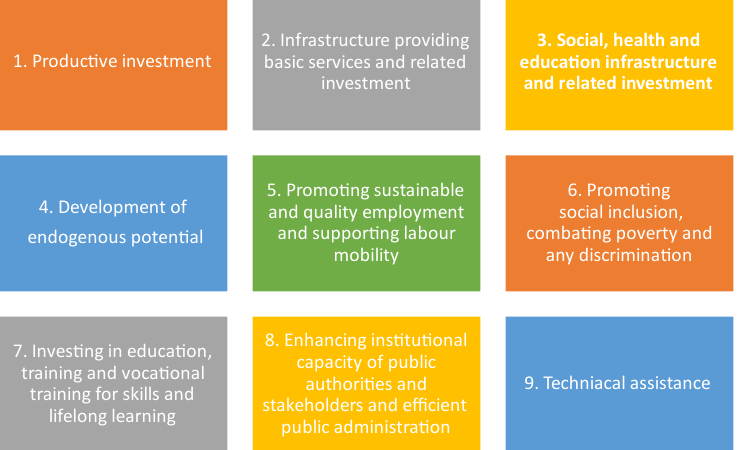
Figure 13. Groups of Interventions in European Regional Development Fund. Source: own study based on [52].